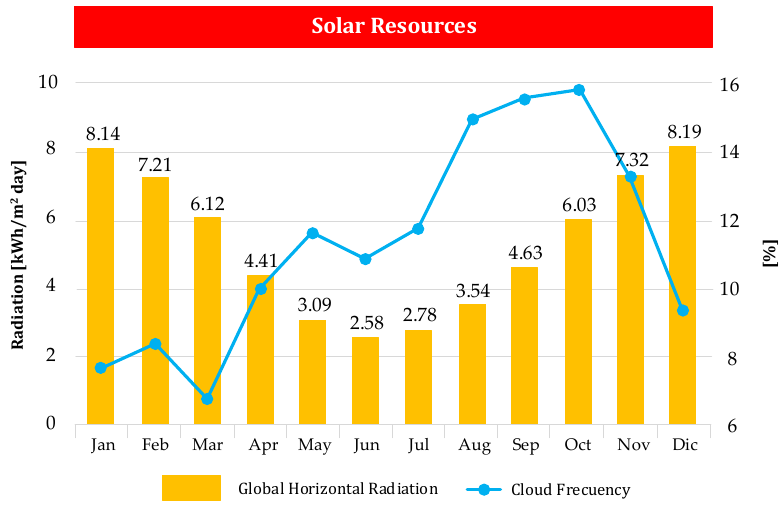
Figure 3. Global horizontal radiation for the county studied.